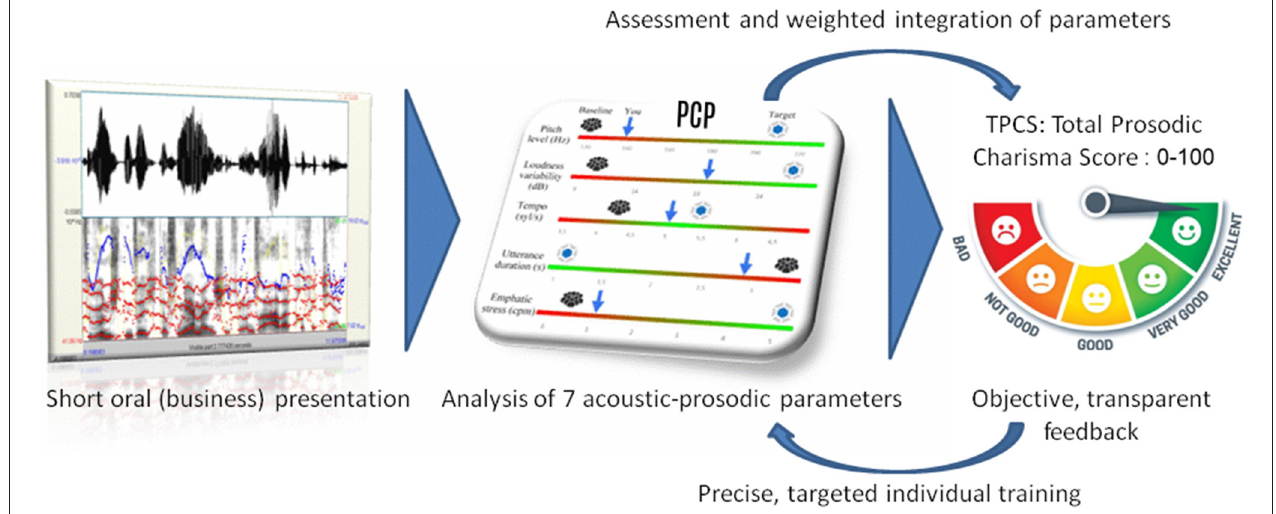
FIGURE 1 | Illustration of the analysis concept and learner output of the Pascal